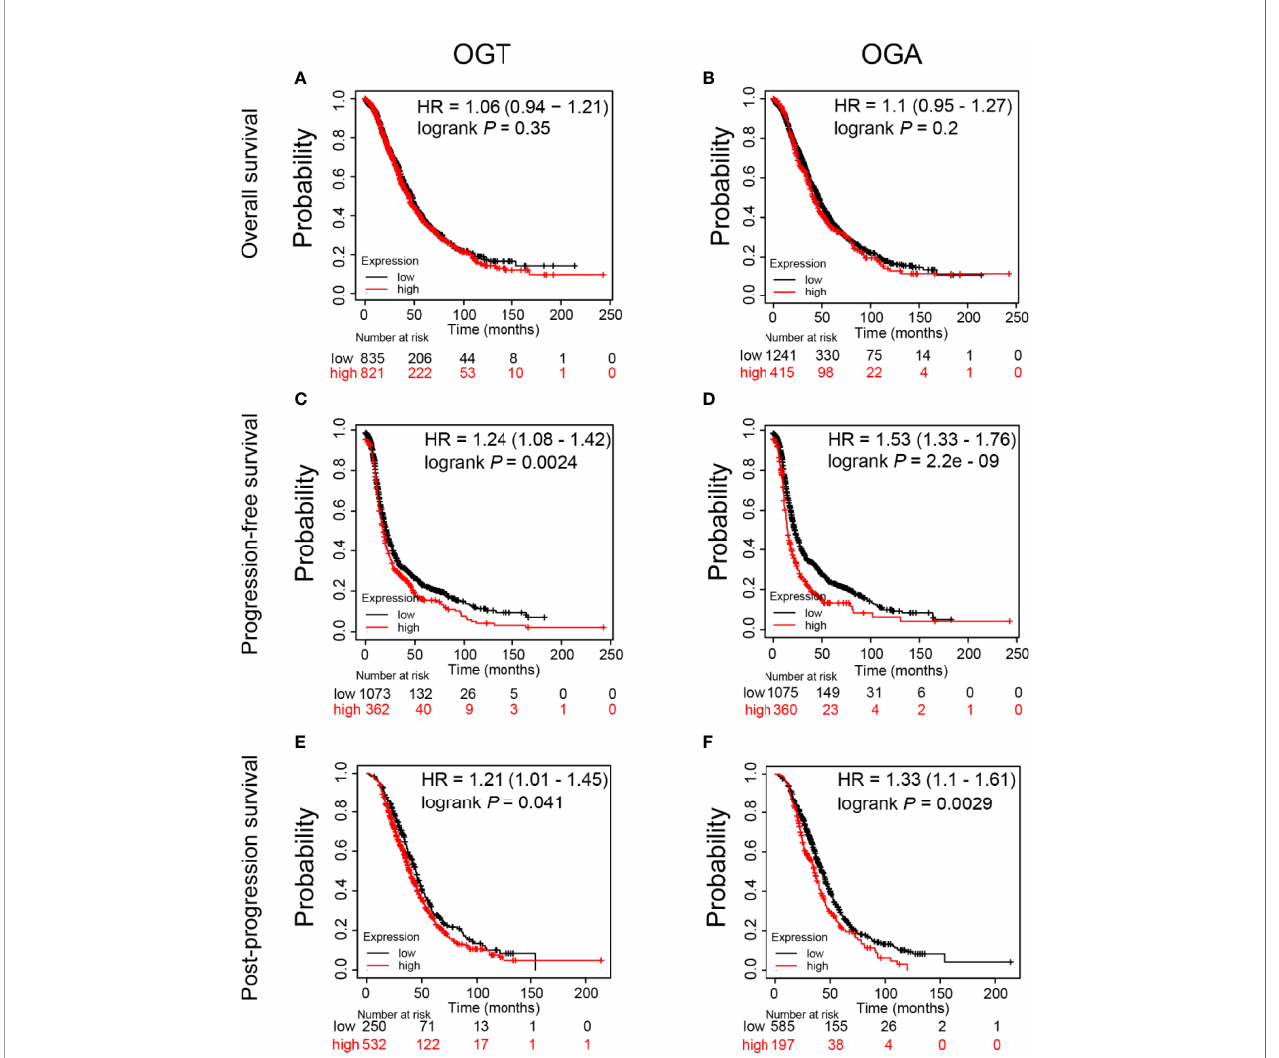
FIGURE 6 | Prognostic value of mRNA expression of OGT and OGA in ovarian cancer patients. (A-B) Impact of OGT/OGA to OS of ovarian cancer patients. (C-D) Impact of OGT/OGA to PFS of ovarian cancer patients. (E-F) Impact of OGT/OGA to PPS of ovarian cancer